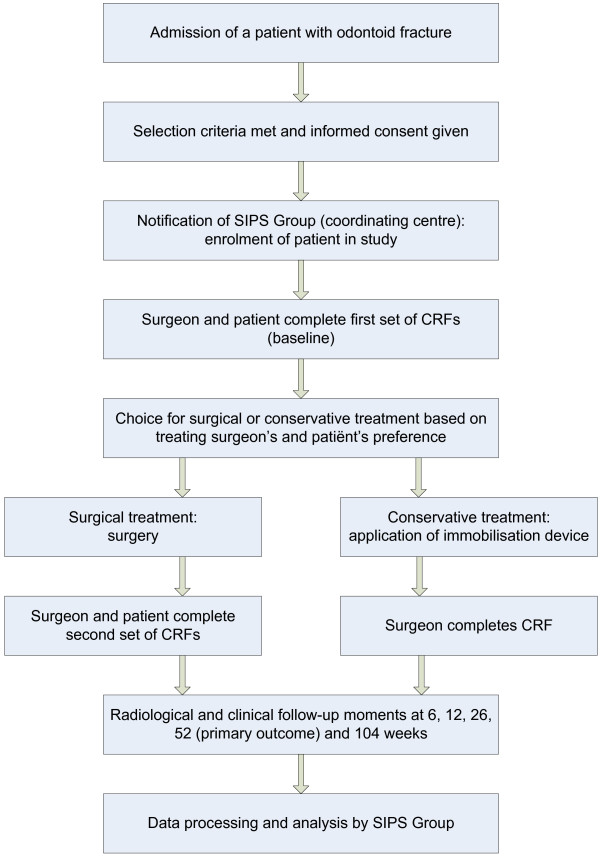
Flow chart of the INNOVATE Trial.